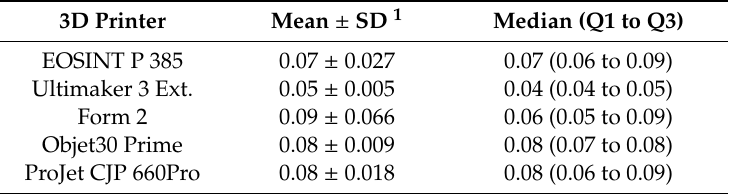
Table 8. Summary of the precision RMS values (mm) for each 3D printer